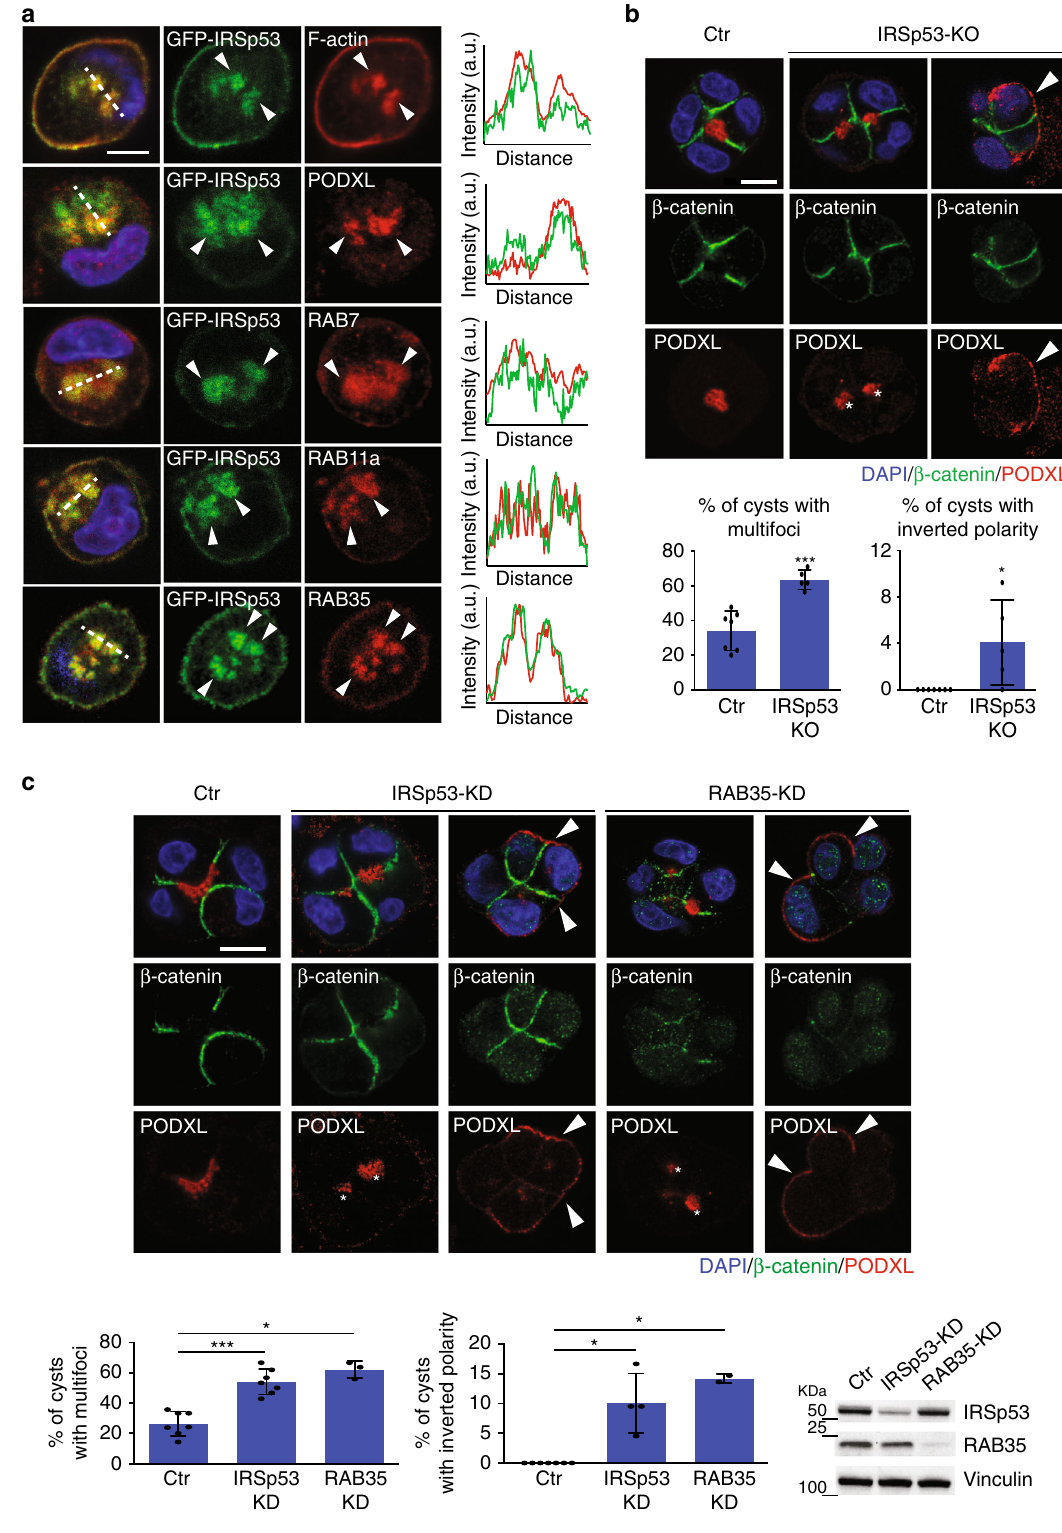
dual depletion of the single baiap2 genes, so in the b2a mutant line or by injection of the b2b-morpholino in WT embryos, did not interfere with normal pronephric duct development (Fig. 8a, Supplementary Fig. 9A, B and Supplementary Fig. 10A). How- ever, injection of b2b morpholinos in the b2a mutant lines